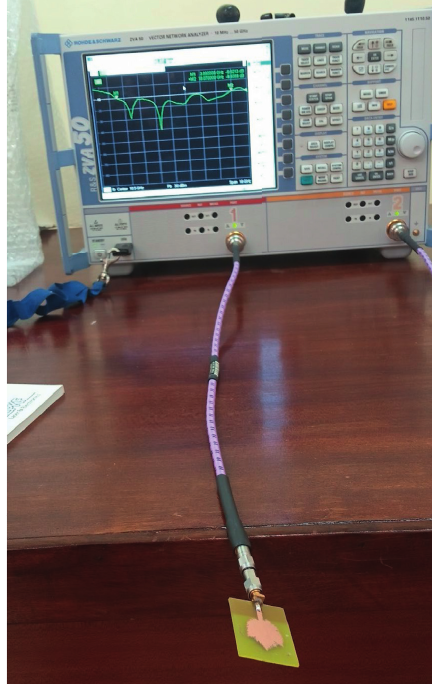
Figure 9: The measurement setup for reflection coefficient of the